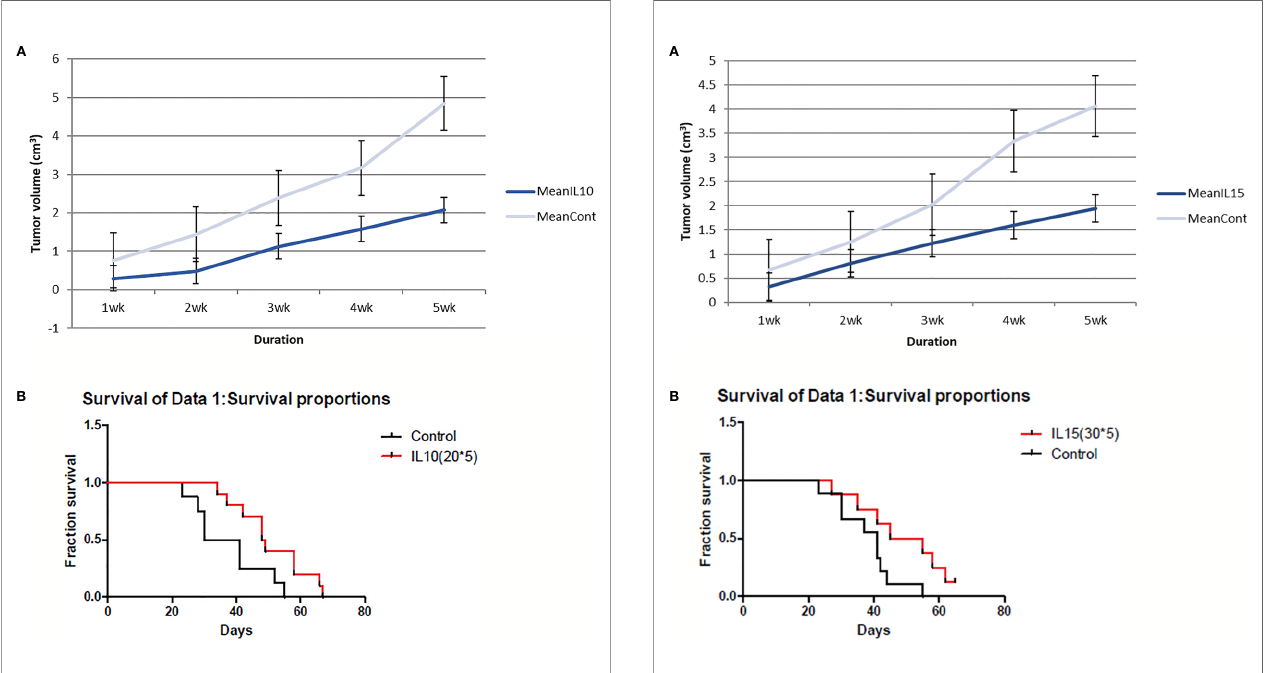
FIGURE 2 | 4T1 tumor volume and mice survival graph after IL-15 injection compared to control mice (n=9 each group). (A) Tumor volume was measured every week after 4T1 cell inoculation with or without IL-15 treatment. Grey line means control group and blue line means the IL-15 group. IL-15 therapy caused statistically signi fi cant tumor volume shrinkage(standard error is used in the graph). (B) Mice survival was measured each week after 4T1 cell inoculation with or without IL-15 treatment. Red line means IL-15 treated group and black line means control group. IL-15 treatment signi fi cantly prolonged mice survival. (Likelihood P value=0.048, median survival for control group=41 days and for IL-15 treated group=50